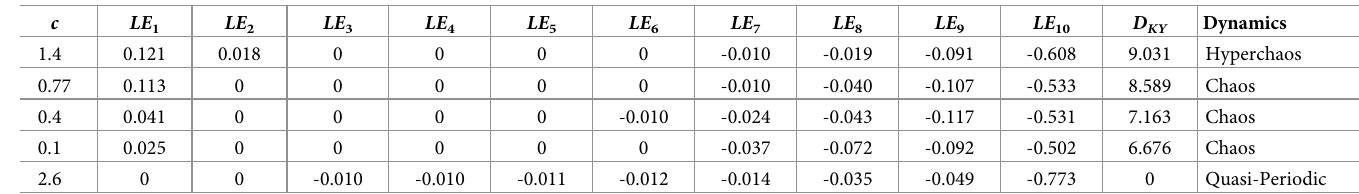
Table 4. Lyapunov exponents, Kaplan-Yorke dimension and dynamics of the new 10D system (1) with parameter c